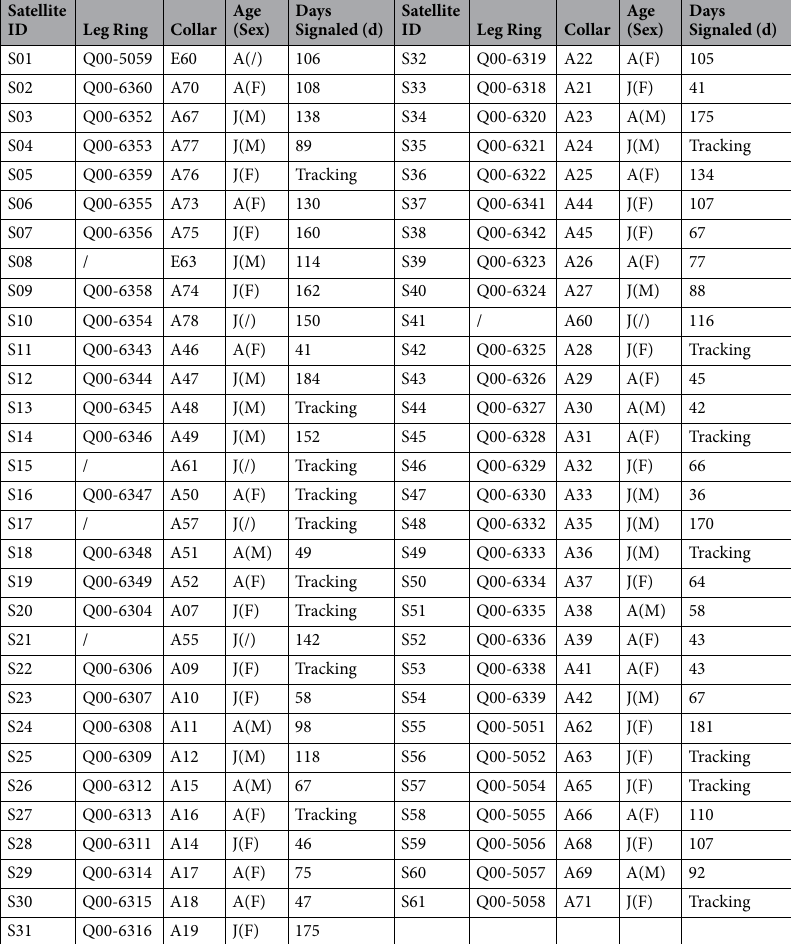
Table 3. Marking information of whooper swans wintering in the Sanmenxia Reservoir area, central China from 2015 to 2016. A: Adult, J: Juvenile, M: Male, F: Female; “/” means no leg